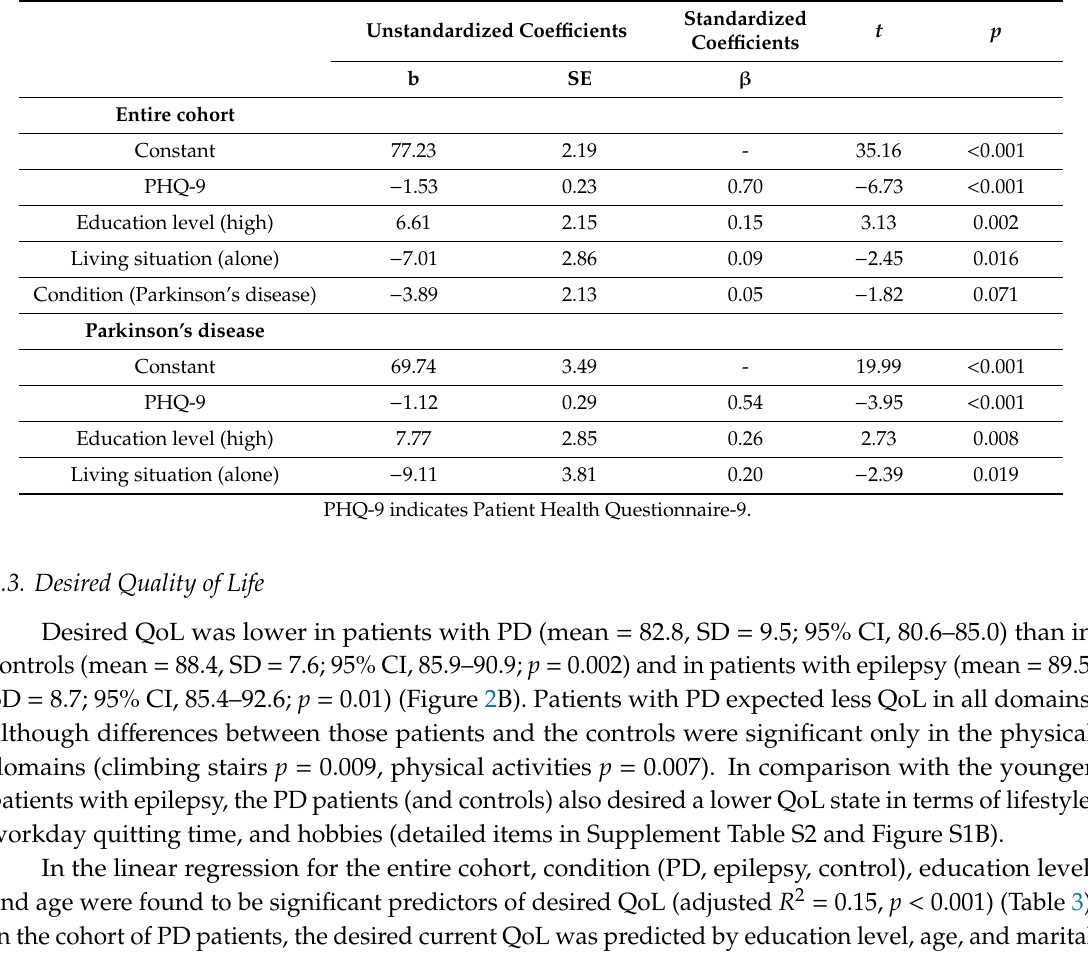
Table 2. Linear regression analysis: Predictors of mean current quality of life.